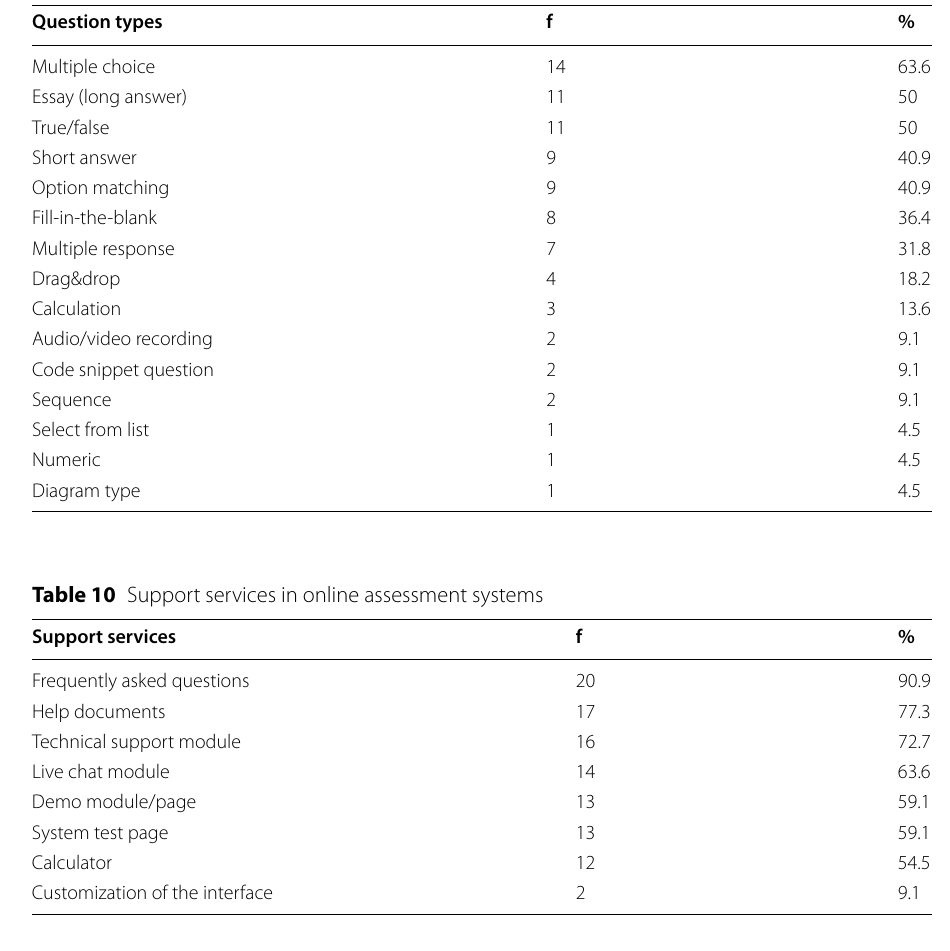
Table 9 Distribution of question types used in online assessment systems